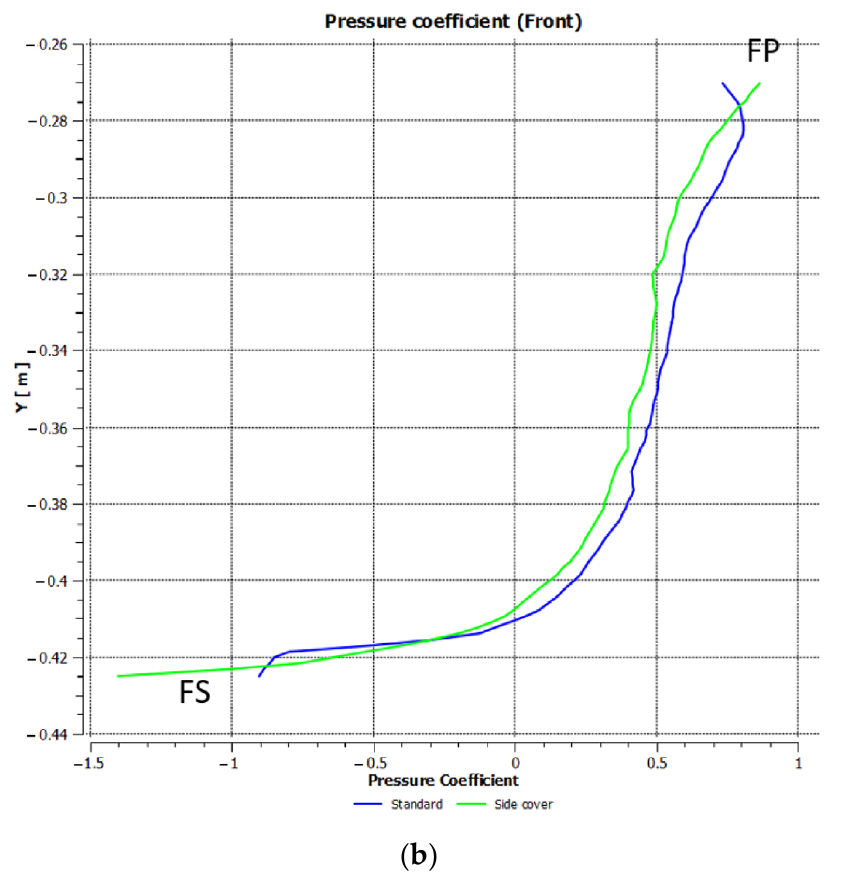
Figure 29. ( a ). Pressure acting on the frontal surface, z = 0.12 m, ψ = 30 degrees. (Left: without side covers; Right: with side covers). ( b ). Comparison of pressure acting on the frontal surface, z = 0.12 m, ψ = 30 degrees. (FP: Front-Port side, FS: Front-Starboard).